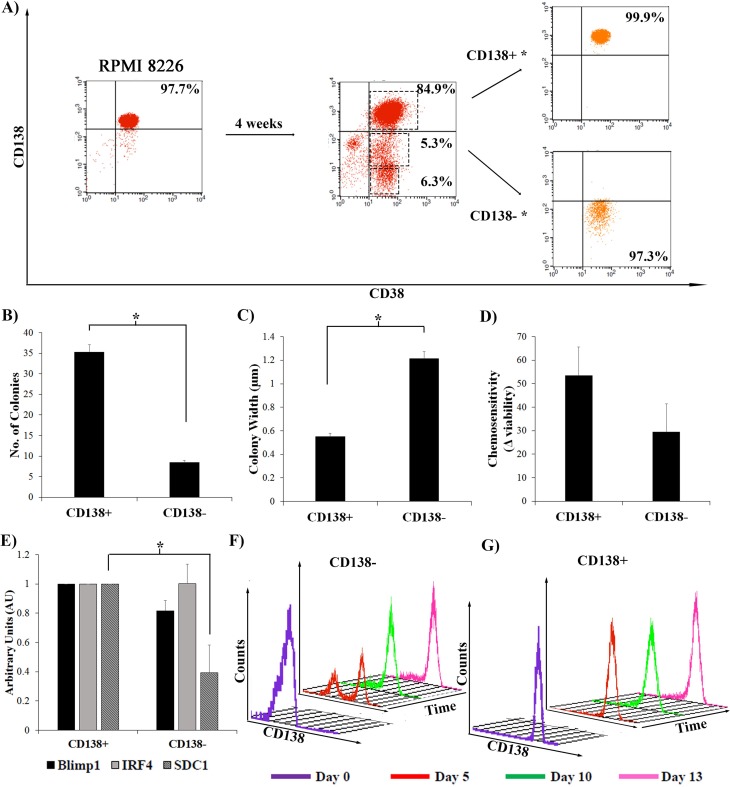
Authenticity of newly dedifferentiated RPMI 8226 CD138- cells.A) Sorted CD138+CD38+ populations were plated for four weeks, and then re-sorted based on CD138 status, to yield newly differentiated CD138+* and dedifferentiated CD138-* populations. Representative of N = 3. Dashed boxes is non-viable (population iii). B,C) These sorted CD138+* and CD138-* cells were plated in methylcellulose, colonies were counted and measured (N = 3) *p<0.05. D) CD138+* and CD138-* cells were plated and treated with Bortezomib for 24 h. Chemosensitivity was measured as the difference in viability before and after treatment (N = 3). E) RT-PCR on CD138+* and CD138-* populations to assess the levels of Blimp1, IRF4, and SDC1 (CD138) (N = 3). The levels seen in CD138+ cells was set to 100, plotted as AU, *p<0.05. Error bars, mean ± SD. F,G) Sorted CD138+* and CD138-* populations were plated, and analyzed for CD138 by flow cytometry at days 5, 10, and 13. Purple line is CD138 content at time of plating (Representative of N = 3).